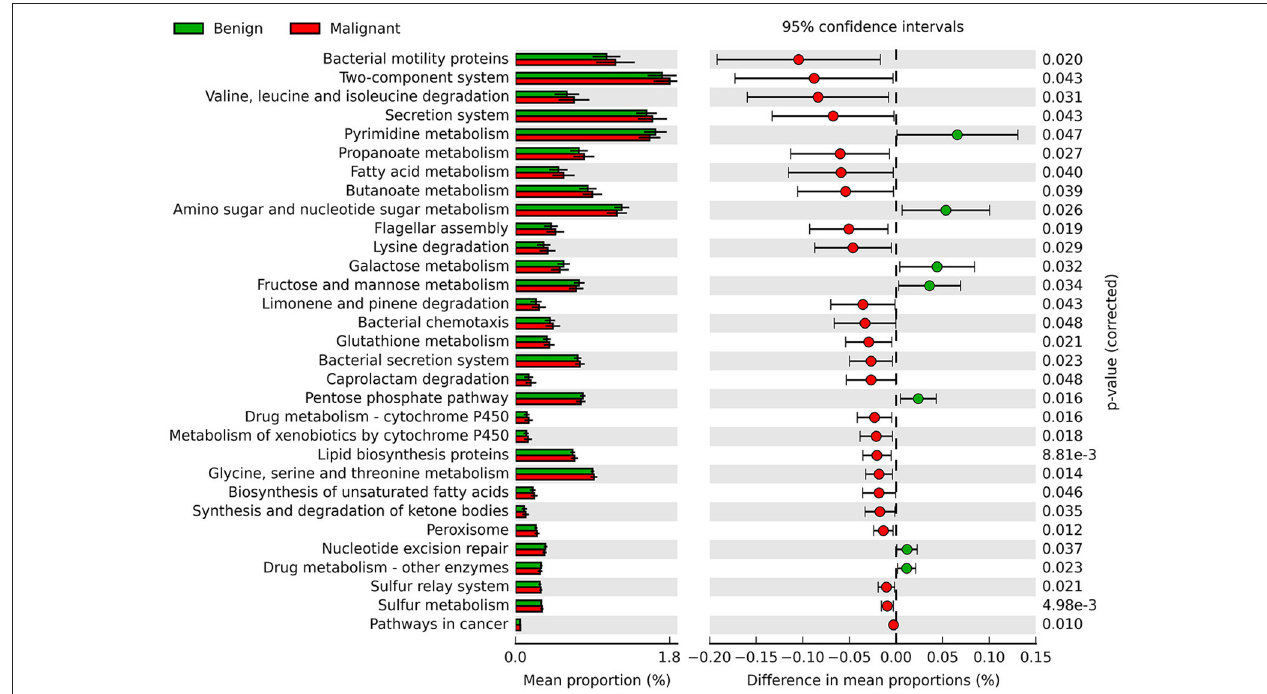
FIGURE 4 | Extended error bar plot showing the significantly different KEGG pathways between benign and malignant tumors. The malignant ones have a positive difference between relative abundances and benign have a negative difference between relative abundances.